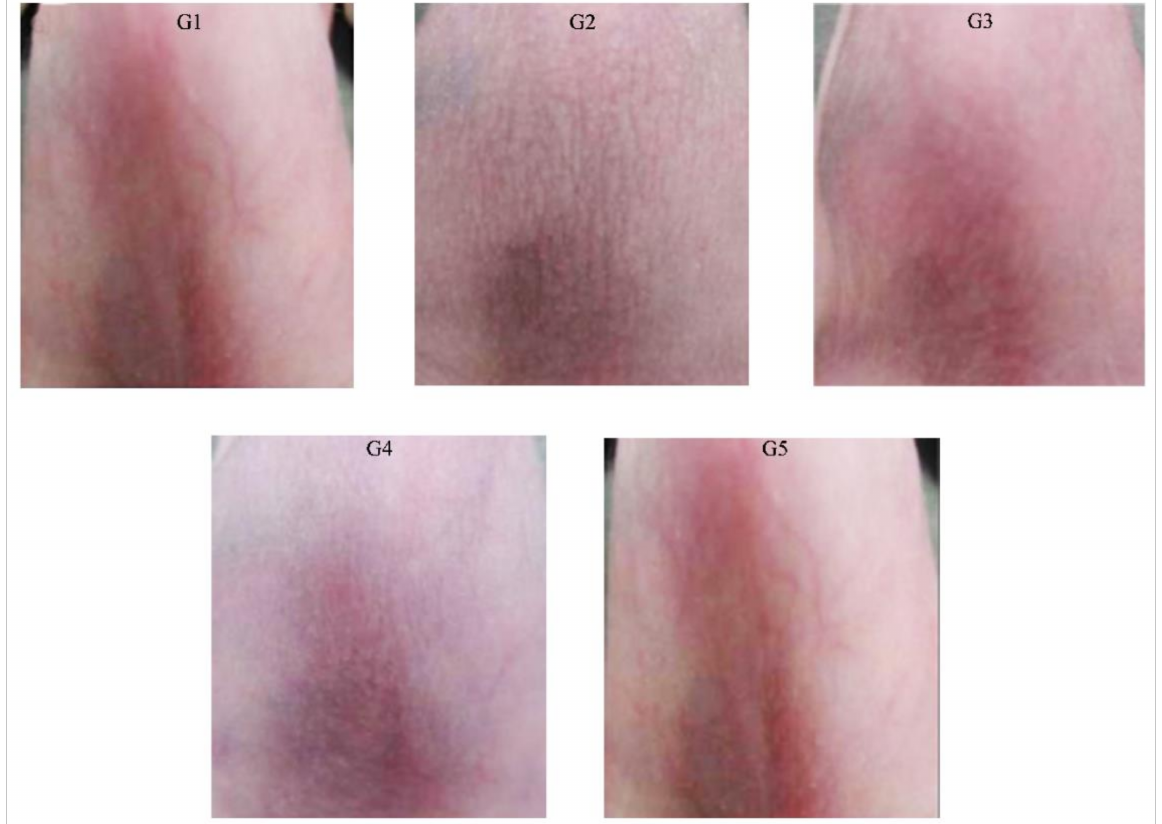
Figure 7. Photographs of hairless mice skins. G1 showed normal skin surface. Thick and deep wrinkles were identified in G2 whereas G3 – G5 showed a very smooth skin surface due to the applied treatment.